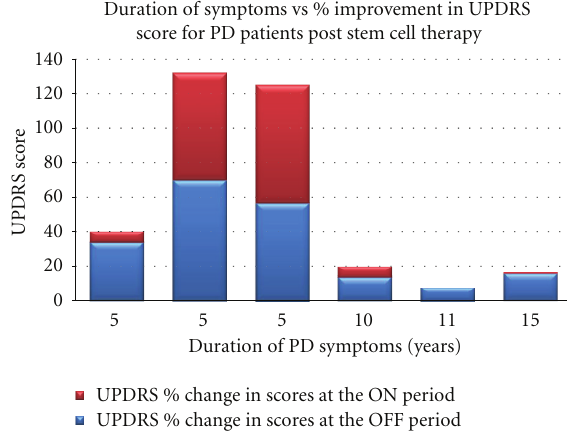
Figure 3: Illustrates the improvement in UPDRS scores for PD pa- tients before and after stem cell transplantation. The graph high- lights the fact that the patients treated early at the onset of the dis- ease (5 years) have shown significantly better improvement which correlates clinically. The patients that were treated between 10–15 years after the diagnosis of PD did not show any significant impro-